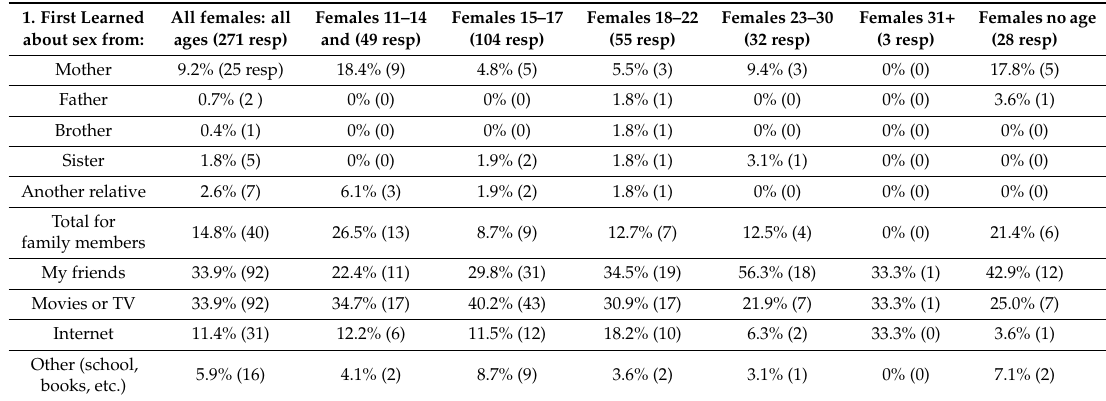
Table 2. First Learned About Sex—All